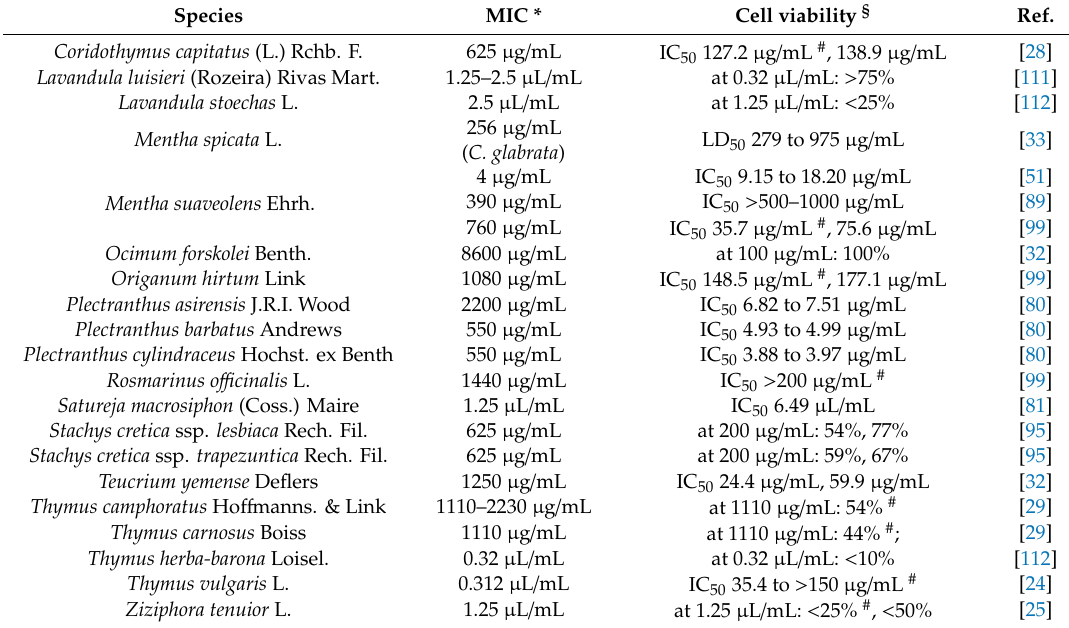
Table 4. Safety profile of 20 EOs from the Lamiaceae